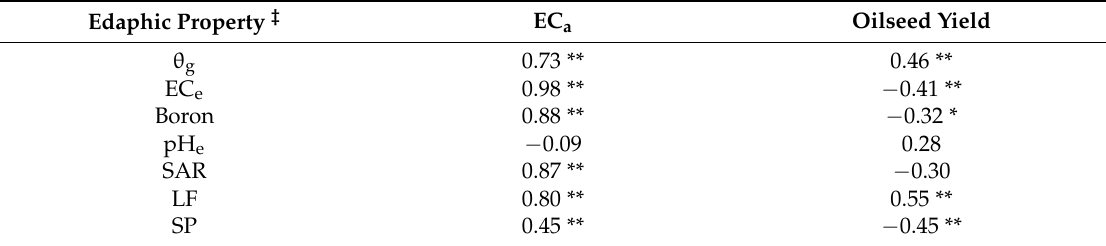
Table 3. Correlation coefficients between edaphic properties and both EC a and oilseed yield that are significantly correlated.